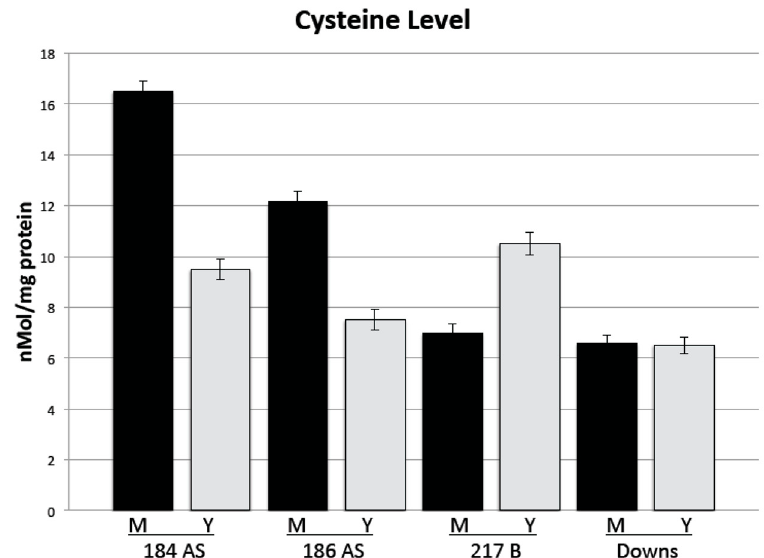
Figure 5. Intracellular cysteine level. M, mold; Y, yeast. Cysteine levels were normalized to protein level. Error bars are the standard error of the mean of triplicate independent experiments.